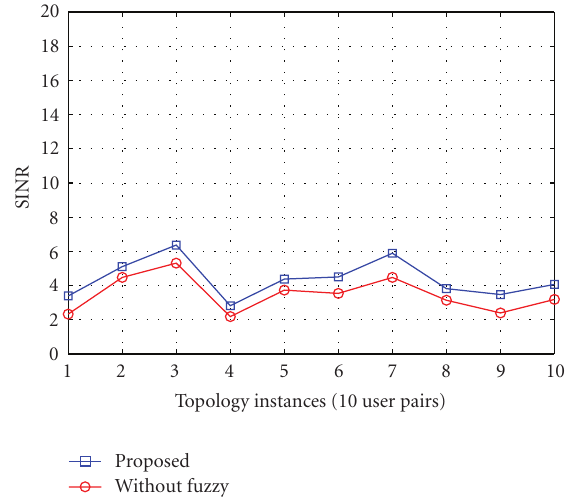
Figure 9: SINR for the original and the proposed algorithm under 25% underestimation of